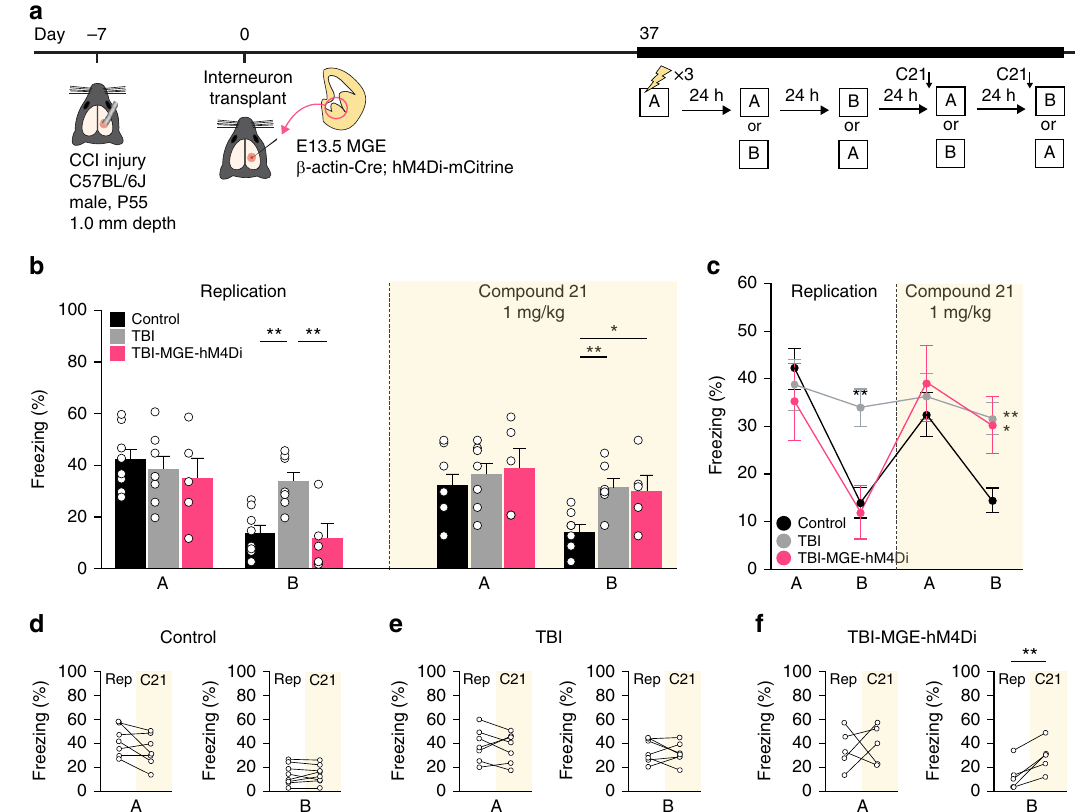
Fig. 6 Silencing transplanted interneurons increases fear memory generalization. a Schematic of the contextual fear conditioning protocol for DREADD- mediated cell silencing. b , c Quanti fi cation of freezing behavior in contexts A and B during the replication experiment and after Compound 21 administration. Replication: ** P = 0.005, control vs TBI; ** P = 0.006, TBI vs TBI-MGE-hM4Di; one-way ANOVA with Bonferroni post hoc test. Compound 21: ** P = 0.01, control vs TBI; * P = 0.03, control vs TBI-MGE-hM4Di; one-way ANOVA with Bonferroni post hoc test. n = 8 control mice, 7 TBI mice, 5 TBI- MGE-hM4Di mice. d – f Quanti fi cation of freezing in contexts A and B for each individual mouse during the replication experiment (Rep) and after Compound 21 (C21) administration. ** P = 0.009, TBI-MGE-hM4Di two-tailed paired t- test. See Supplementary Data 1 for statistical analyses. Error bars, s.e.m. Source data are provided as a Source Data fi